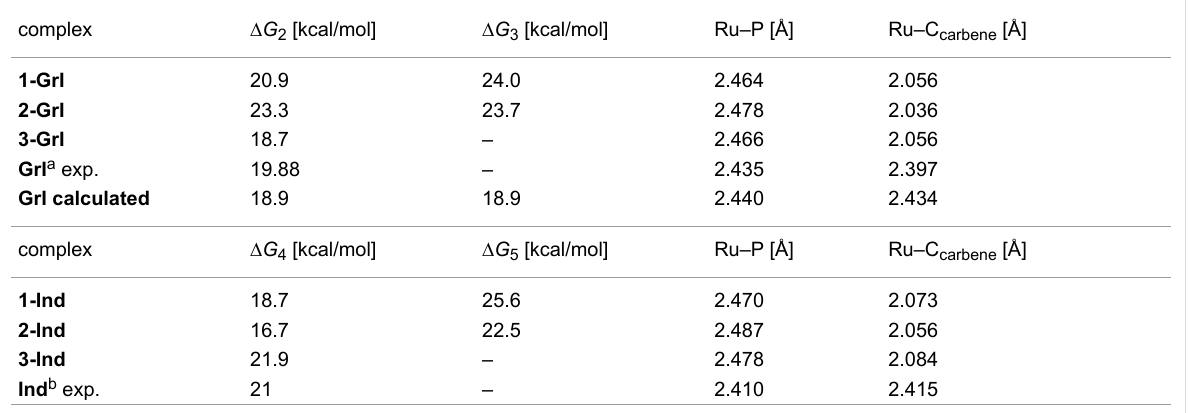
Table 2: The comparison of dissociation energies ∆ G 2 – ∆ G 5 and structural parameters of investigated compounds. complex